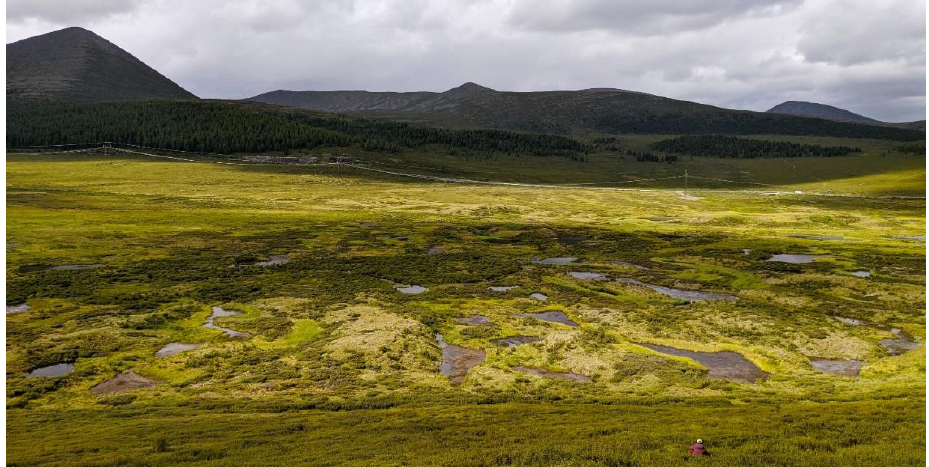
Figure 3. Adyr-Khem river valley at Alash plateau; southern slope of the Western Sayan montane region, Republic of Tuva, Russia (photo by Kvasnikov, 30 July 2020).